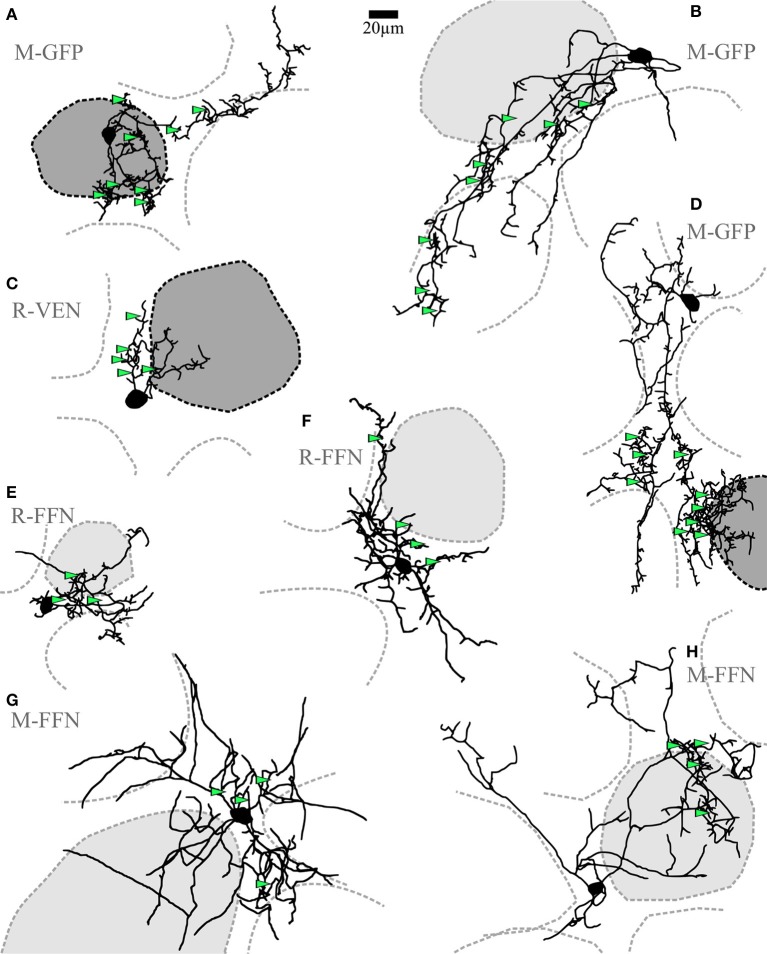
Clasping cells (CCs). (A–H) Maximal z-projections of reconstructions of individual representative CCs with indicated surrounding glomeruli. The “parent glomerulus” is shaded for each cell (see methods). Darker shades indicate that the cell arborizes within the glomerular neuropil (A,C,D), whereas light shades indicate non-innervated parent glomeruli. Non-shaded structures are surrounding glomeruli, which the dendrites do not ramify in and which do not constitute the parent glomerulus. Green arrowheads indicate the position of clasped JGC somata. Most dendritic structures including cell body clasps do not ramify in the intraglomerular neuropil, with the exception of a few superficially entering branches, also including dense clasp-like bundles (A,C,D). R-VEN, VGAT-Venus+ cells in juvenile rats; R-FFN, FFN102+ cells in juvenile rats; M-FFN, FFN102+ cells in adult mice; M-GFP, DAT-GFP+ cells in adult mice.